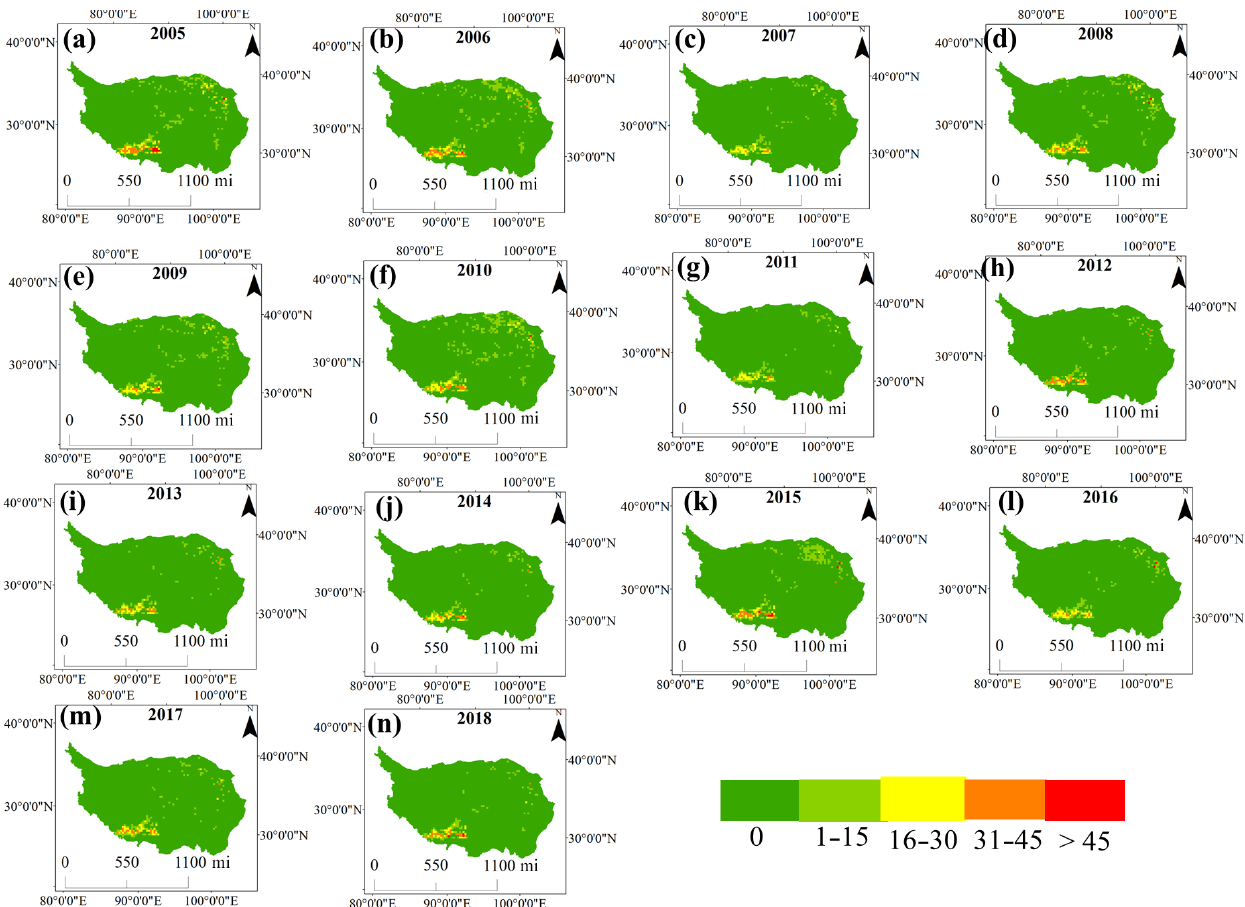
Figure 10. The spatial distributions of nonattainment days on the Tibetan Plateau during